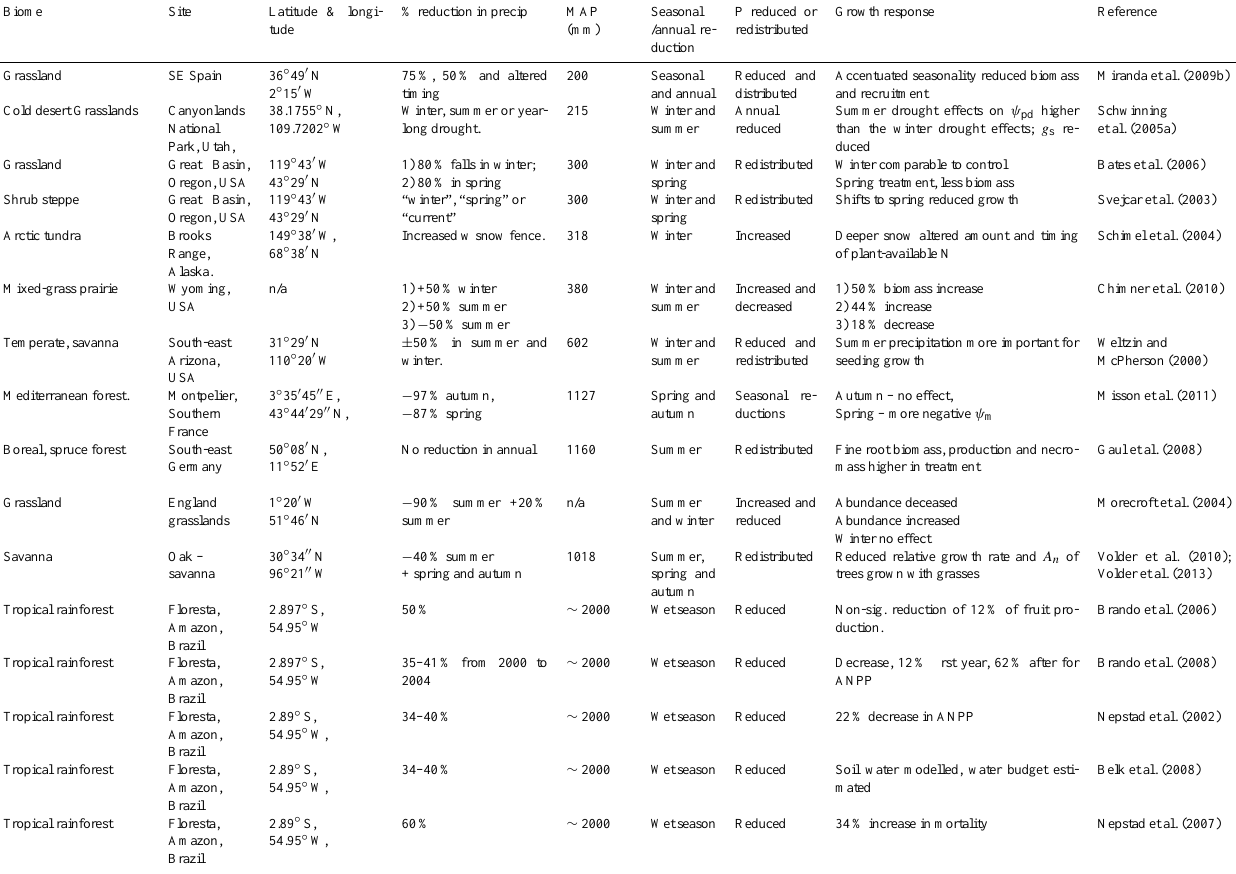
Table 1. Responses of vegetation to changed seasonal precipitation. Biome, site location, latitude and longitude, experimental reduction in precipitation, mean annual precipitation (MAP), and description of whether experimental reduction in precipitation ( P ) was reduced or redistributed, in addition to the measured response and source reference. Results represent a selection of studies and are not a compre- hensive list. Abbreviations: ANPP = above-ground net primary productivity; A n = photosynthesis; ψ m = midday leaf water potential (kPa); ψ pd = predawn leaf water potential; g s = stomatal